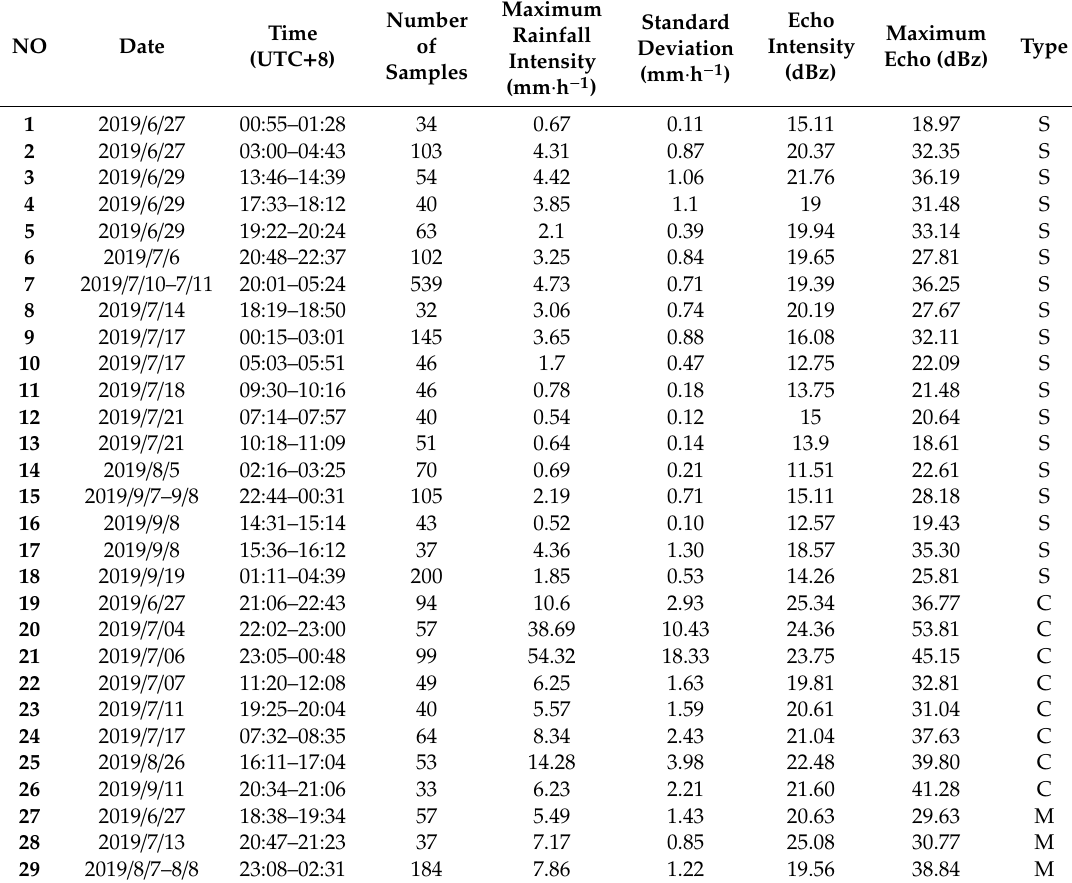
Table A1. Samples of di ff erent types of precipitation (S-stratiform, C-convective, and